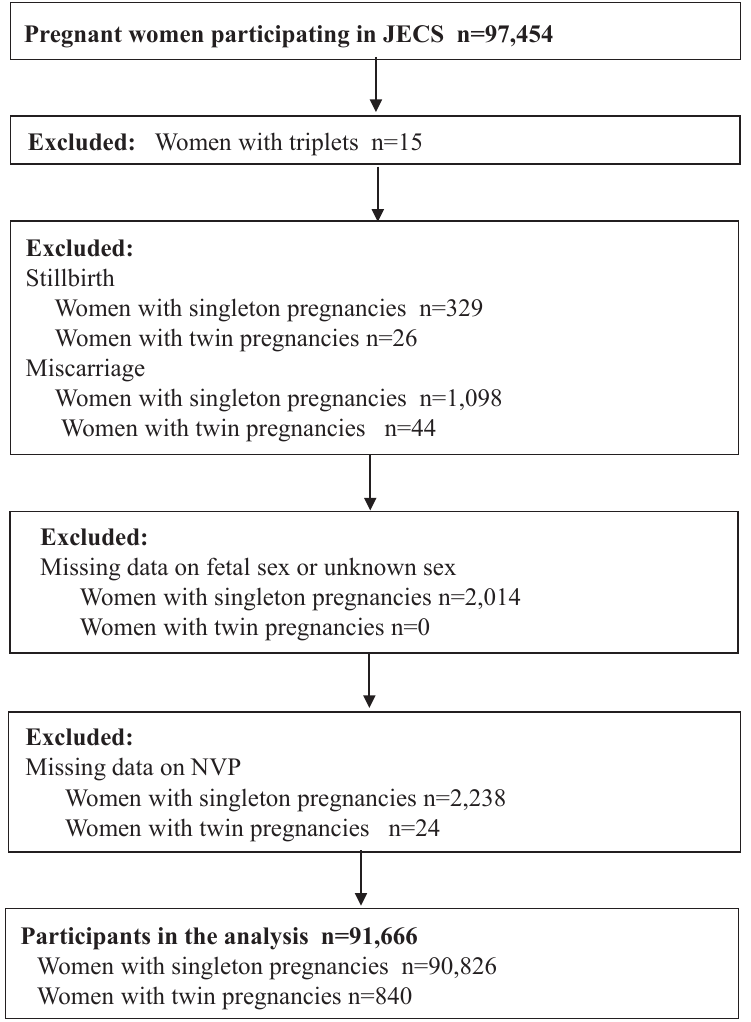
Figure 1. Flow chart for selection of participants from